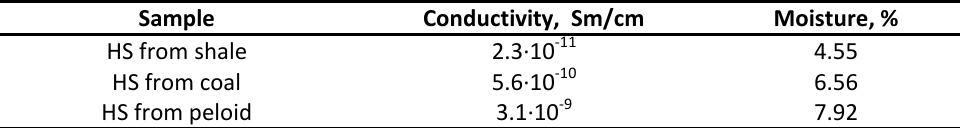
Fig. 3. Scanning electron microscope image of humic Fig. 4. Scanning electron microscope image of humic substances isolated from shale substances (isolated from shale) after alkaline hydrolysis Conductivity of all studied HS varied within 10 -9 - 10 -11 Sm/cm (Tab. 6), it is shown that these HS are kind of dielectrics. Table 6. Conductivity of Humic based